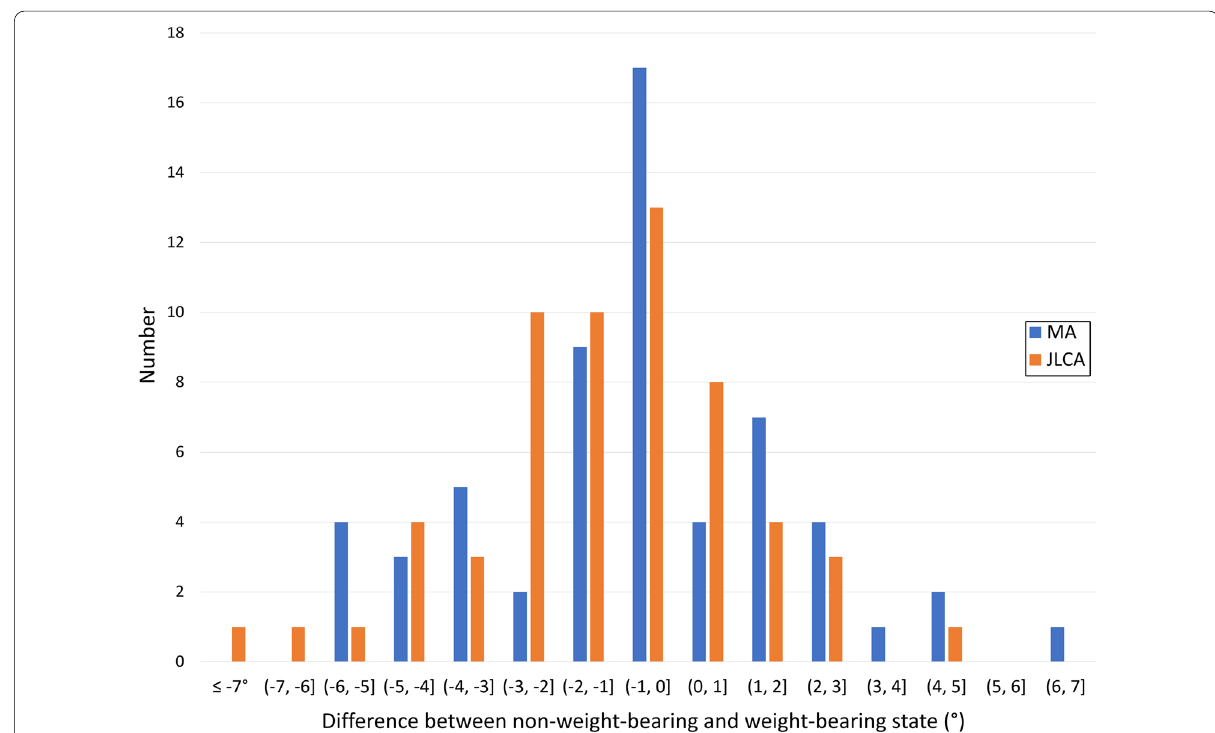
Fig. 6 Distribution of differences between non-weight-bearing and weight-bearing states for MA and JLCA. 37.3% and 40.7% of all patients have differences of 2° or more between weight-bearing and non-weight-bearing positions for MA and JLCA,